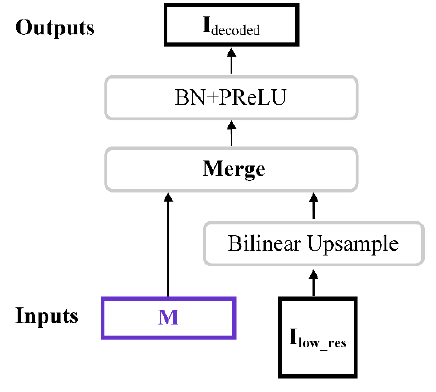
Figure 3. Structure of a SAPC2 Decoder.